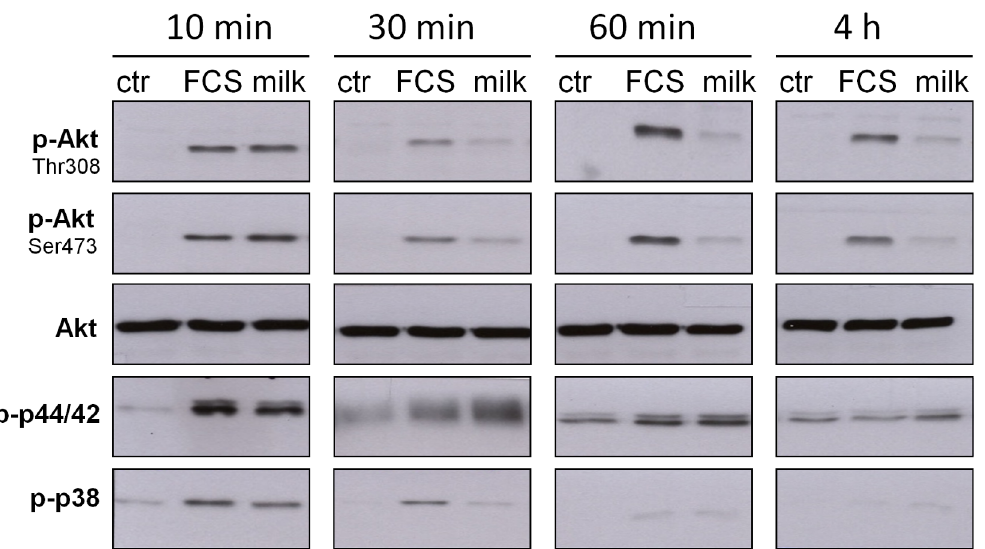
Fig 4. Bovine milk activates signaling molecules. Time course of PKB/Akt, p44/42 and p38 phosphorylation in human fibroblasts. After serum starvation for 24 hours cells were treated with either 10% FCS or 10% bovine milk for 10, 30, 60 minutes or 4 hours. Cells held under FCS-free conditions served as control (ctr). Proteins were obtained as described in “ Materials and Methods ” , and Western blotting was performed with phosphospecific antibodies. Equal loading was monitored by using antibodies directed against total PKB/Akt. The blot shows representative results. (n = 3).